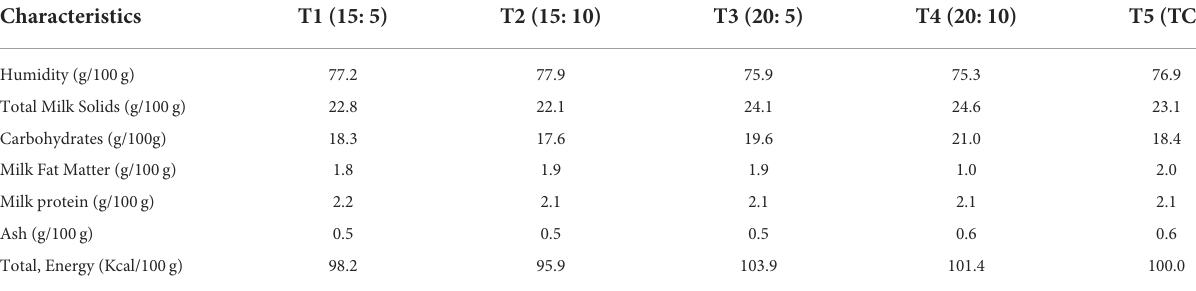
TABLE 4 Physicochemical characteristics of Mangifera indica and Myrciaria dubia yogurt.